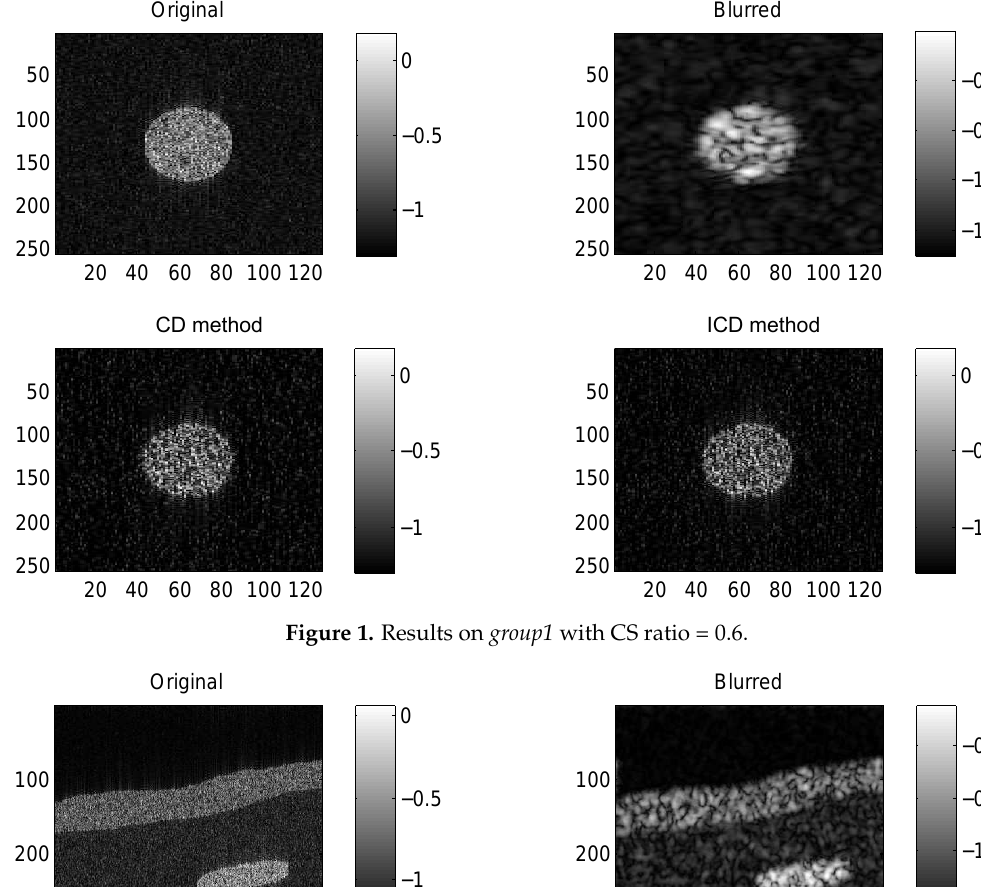
Figure 1. Results on group1 with CS ratio = 0.6.